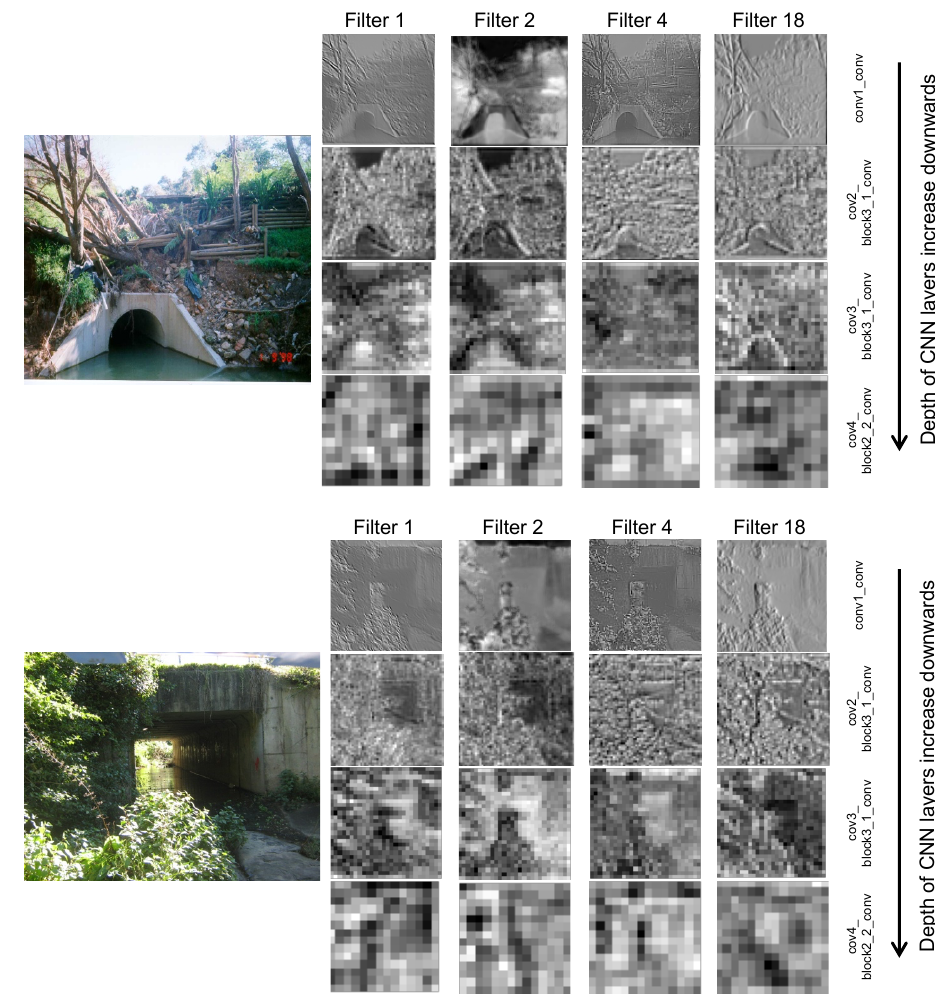
Figure 9. Selected false positive (First row) and false negative (Second row) instances.